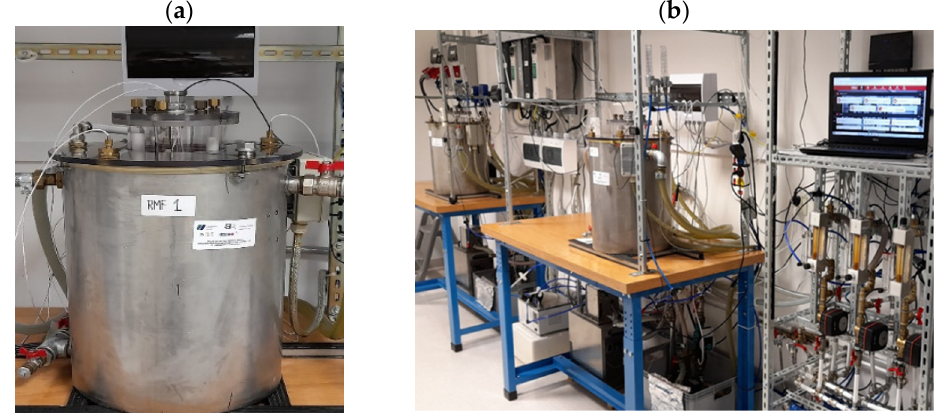
Figure 10. ( a ) RMF generator with ( b ) monitoring and control